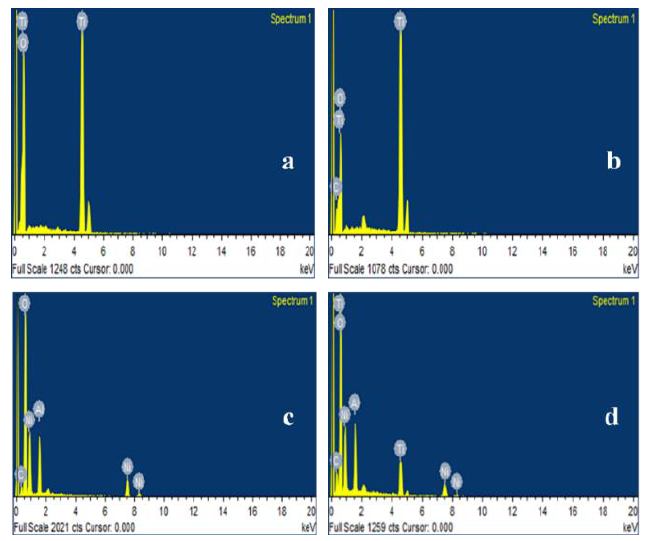
Figure 5. EDS spectra for ( a ) TiO 2 , ( b ) TiO 2 -C, ( c ) NiAl-LDH and ( d ) TiO 2 -C/NiLDH amalgam.